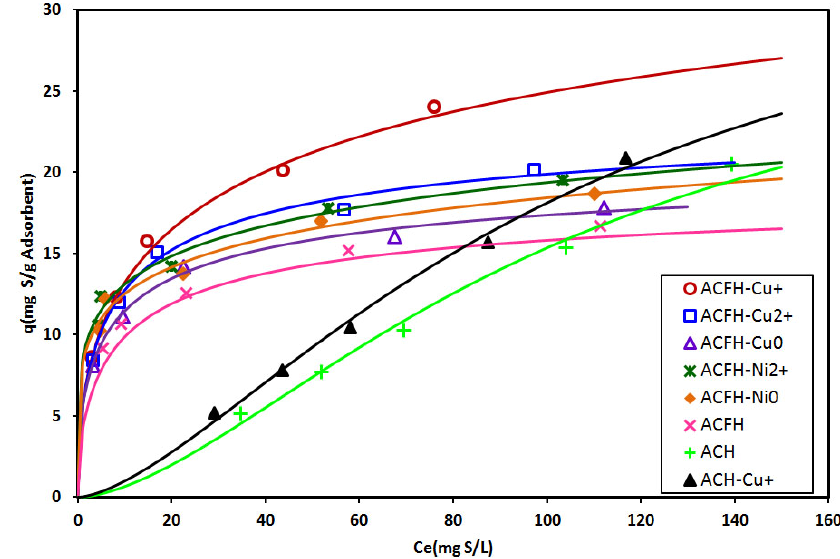
Figure 3. Adsorption isotherms of DBT onto activated carbons impregnated with different copper and nickel species. Solid lines represent Langmuir-Freundlich fit of the data.